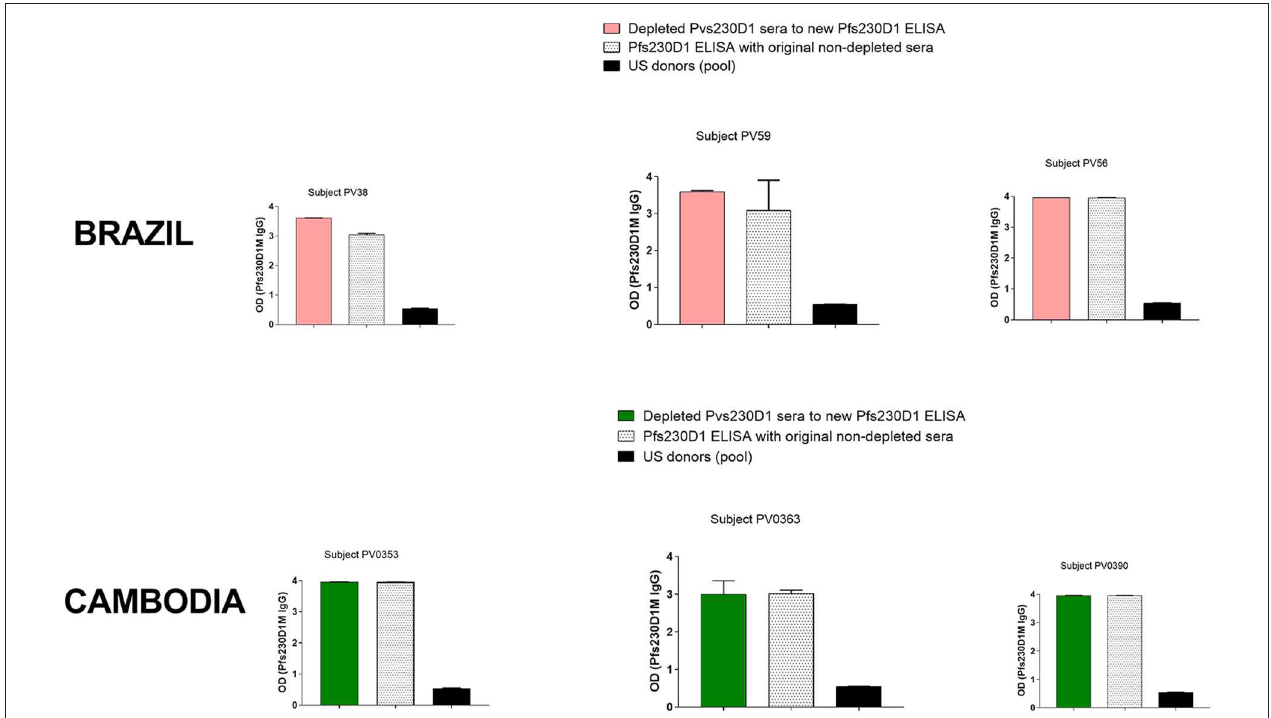
FIGURE 9 | ELISA on Pvs230D1M-depleted sera. Pvs230D1M IgG levels were gradually reduced in sera by depletion assay ( Figure S2 ), and then samples were submitted to ELISA against Pfs230D1M. Specificity of depletion was confirmed measuring antibody titers to PvDBP-RII in sera depleted for Pvs230 IgG ( Figure S3 ).